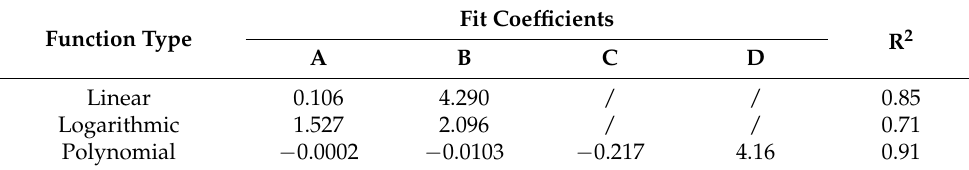
Table 6. Regression and correlation coefficients for peak stress vs. growth temperature fitting functions.